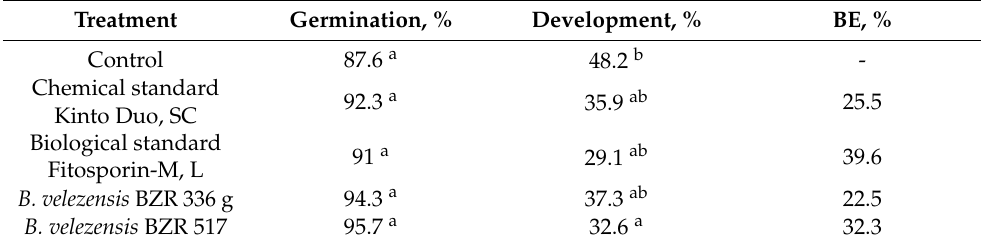
Table 2. Biological efficacy (BE, %) of B. velezensis BZR 336 g and B. velezensis BZR 517 against F. graminearum BZR 4 on winter wheat in a climatic chamber. Treatment Germination, % Development,